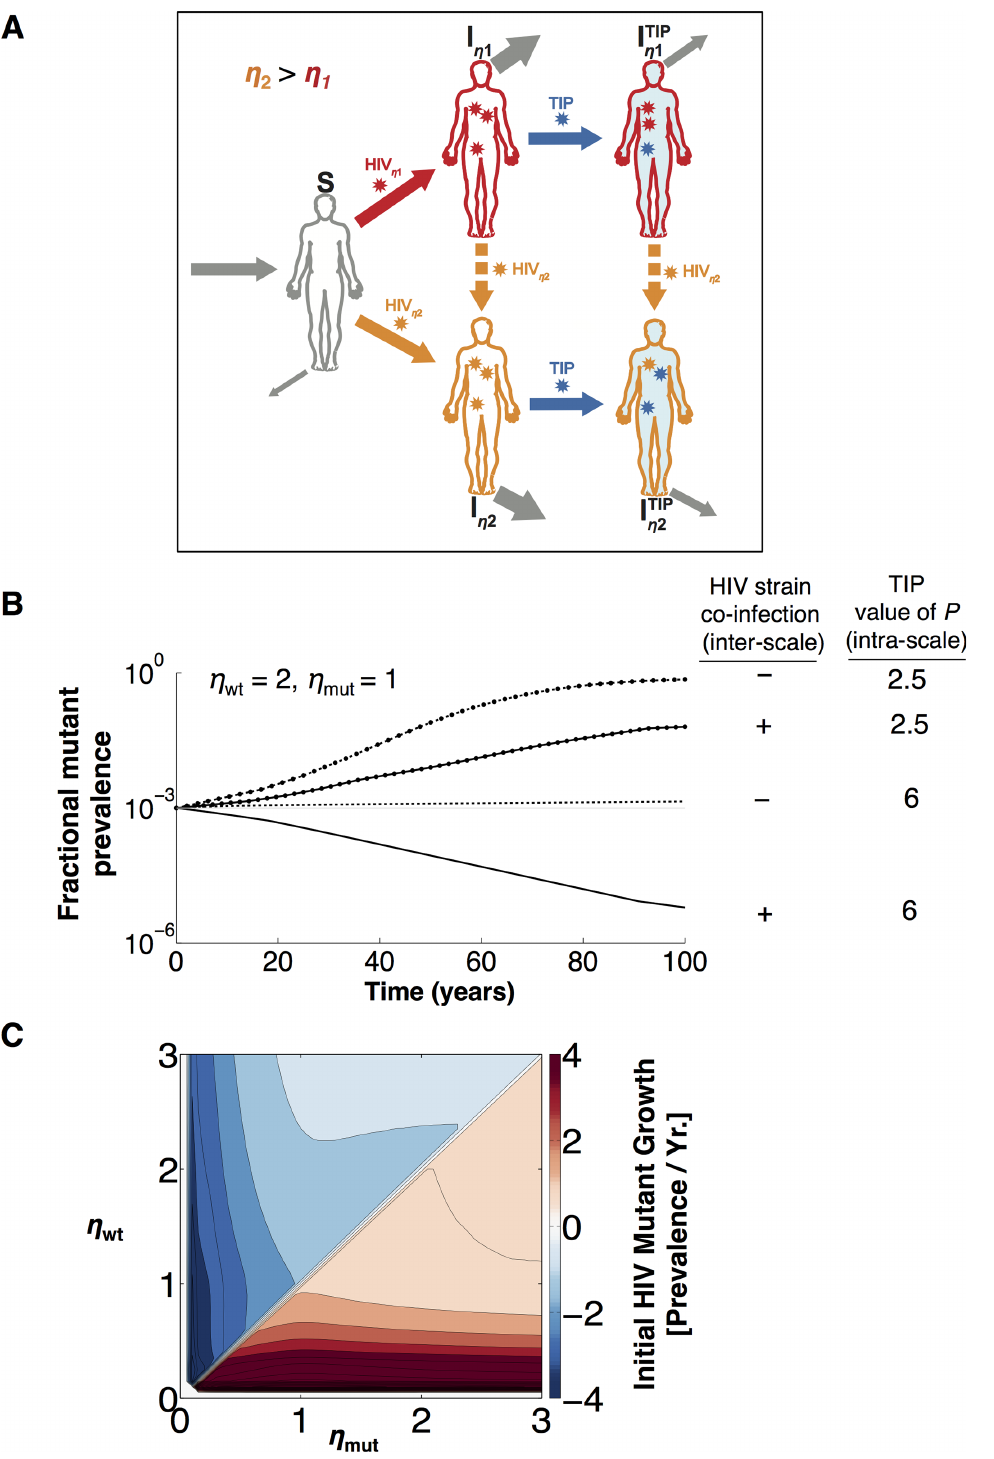
Fig 3. Conflicting selection pressures prevent the outgrowth of TIP-resistant HIV mutants in a host population. (A) Schematic of extended model built to examine the outcome of the evolutionary conflicts. Two HIV strains with different η values compete for transmission across a TIP-exposed population (Eqs. 100 – 104 in S1 Text). When multiple HIV strains co-infect the same individual, the HIV strain with highest η outcompetes all other HIV strains due to its higher replicative fitness (see Fig 2B); this host-level outcome occurs rapidly compared to dynamics on the population-scale (enabling a time-scale separation). (B) Projected spread of HIV mutants with reduced η values across a TIP-treated HIV population. The wild-type HIV strain has η wt = 2 and